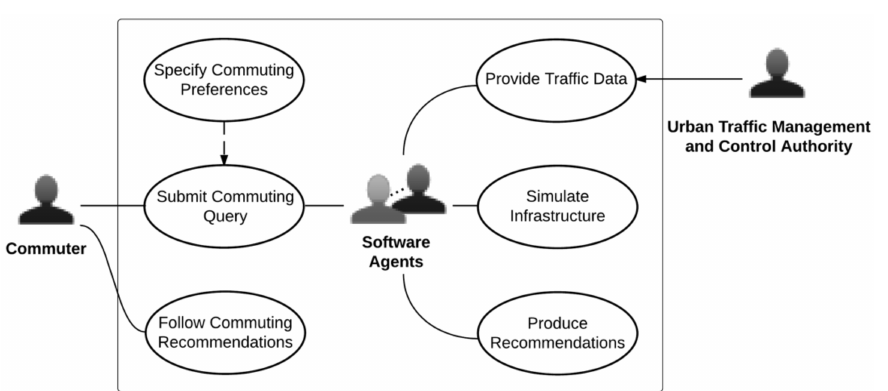
Figure 3. Main use cases of the eco-friendly route recommender